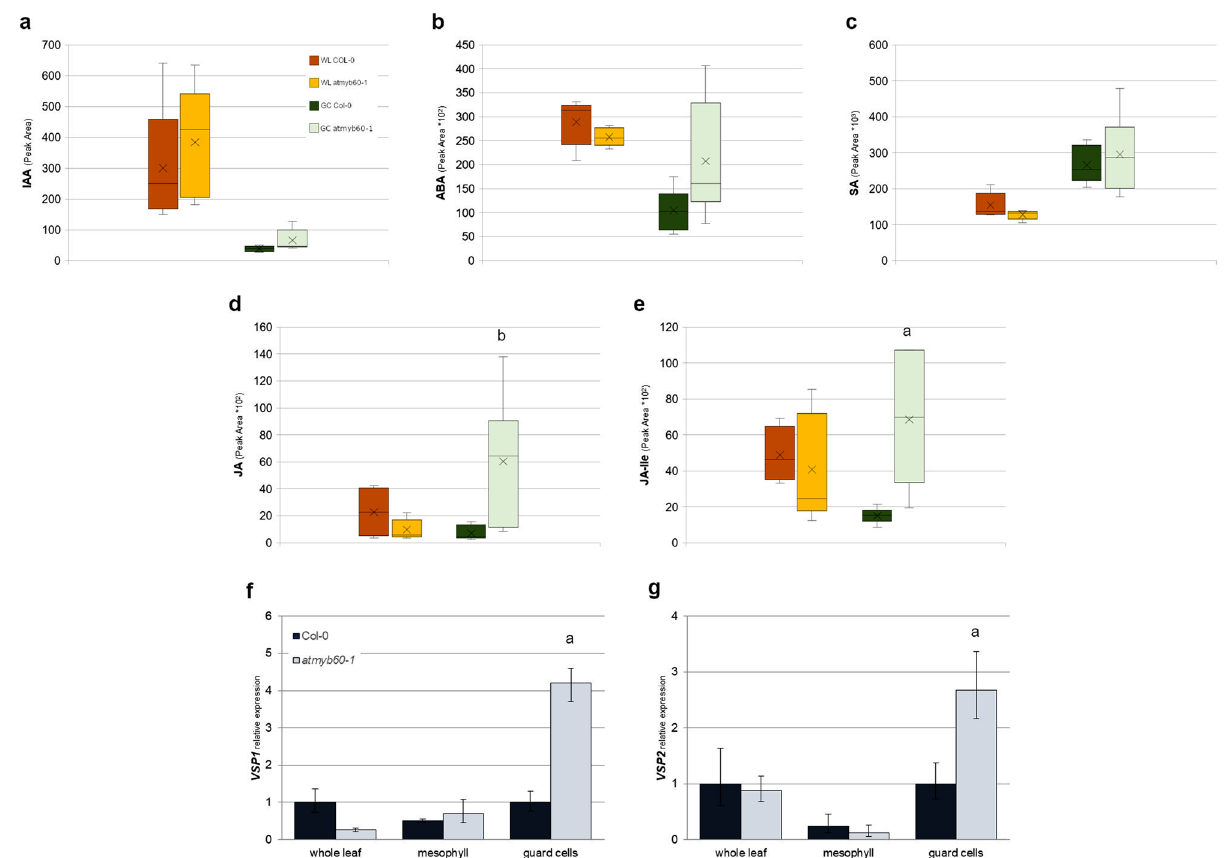
Figure 1. Guard cells from the atmyb60 -1 mutant over-accumulate JA and JA-Ile. ( a – d ) quantitative analysis of IAA ( a ), ABA ( b ), SA ( c ), JA ( d ) and JA-Ile ( e ) in whole leaves (WL), or epidermal fractions enriched in guard cells (GC). ( f – g ), qPCR analysis of Vsp1 ( f ) and Vsp2 ( g ) expression in whole leaves and laser-microdissected mesophyll or guard cells. Relative gene expression was normalized to the expression of the AtACTIN2 gene. “a” and “b” indicates significant differences between wild type and atmyb60-1 samples at P < 0.01 and P < 0.05, respectively ( t